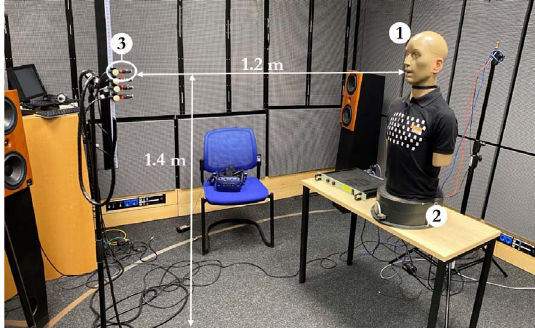
Figure 2. Measurement setup with the KEMAR head (1), the turntable system (2) and a microphone array (3) using exclu- sively the top microphone in this